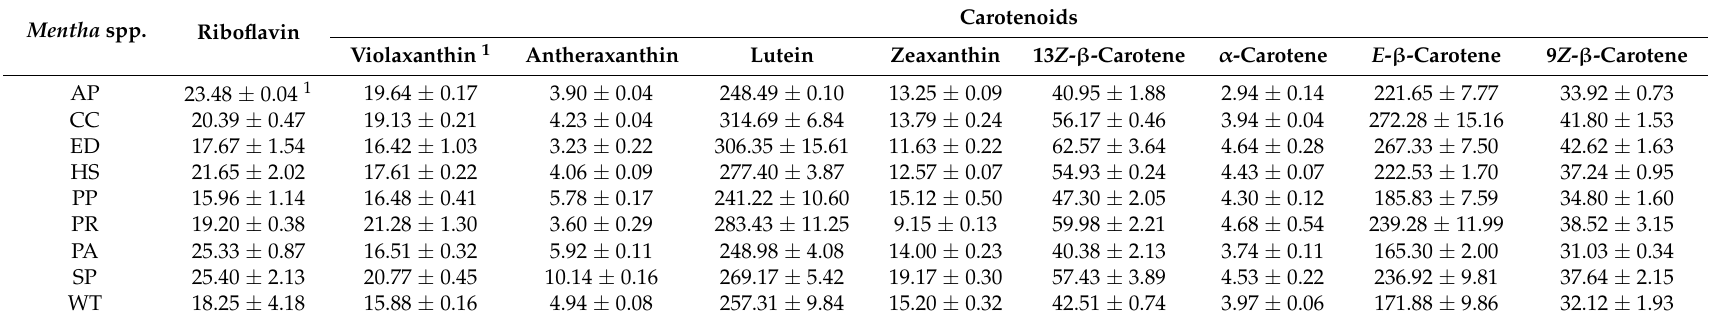
1 The data are presented in this table as mean ± standard deviation of three biological replicates ( n = 3). 2 n.d., not detectable. AP, apple mint; CC, chocolate mint; ED, eau de cologne mint; HS, horse mint; PP, peppermint; PR, pennyroyal mint; PA, pineapple mint; SP, spearmint; WT, water mint. Table 2. Composition and content of carotenoids and riboflavin in different Mentha species ( µ g/g DW). Mentha